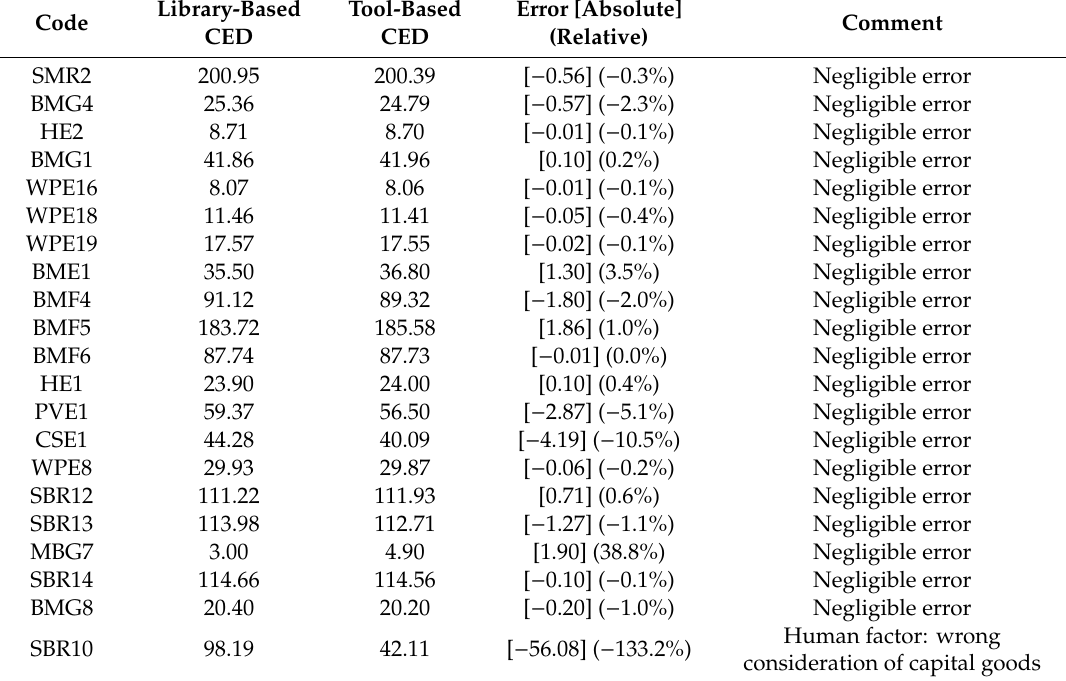
Table 2. Library- and tool-based harmonised non-renewable energy footprints of hydrogen (MJ per functional